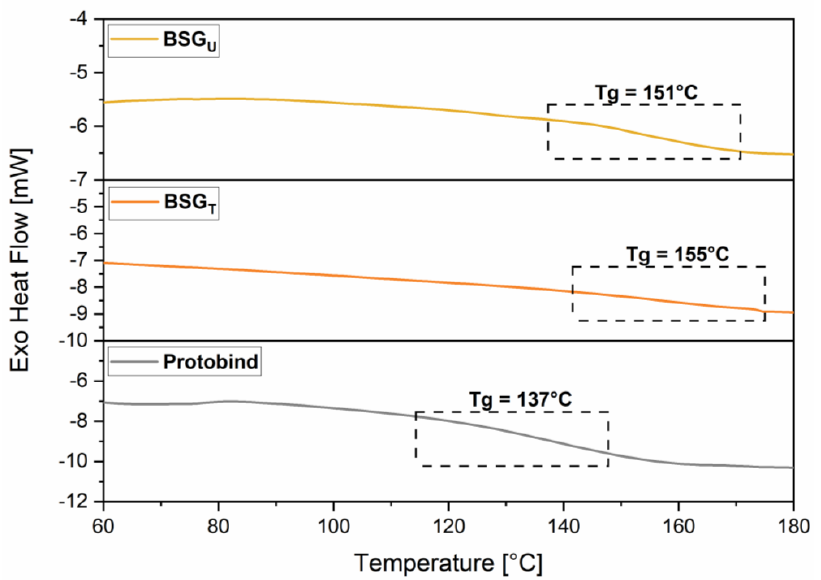
Figure 8. DSC curves of BSG U Lignin, BSG T Lignin, and Protobind 1000.